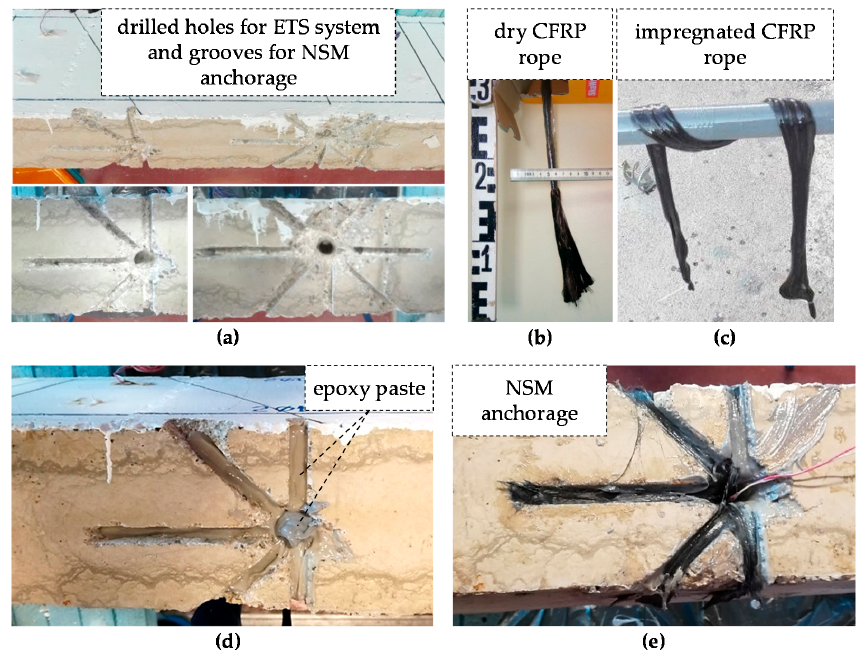
Figure 3. Strengthening application stages of the rectangular beam: ( a ) drilled holes through the web and radial grooves at the top and the bottom of the beam; ( b ) carbon fibre-reinforced polymer (CFRP) rope before impregnation; ( c ) impregnation of the CFRP rope using impregnating resin; ( d ) filling of the drilled holes and the grooves of the anchorage region with a resin gun using epoxy paste; ( e ) insertion of the impregnated CFRP ropes inside the holes and anchorage of their free length inside the grooves using supplementary epoxy paste.